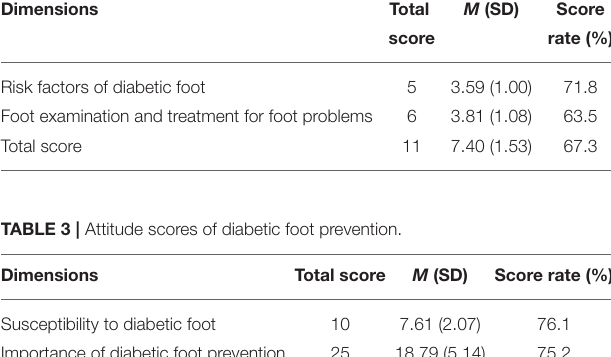
TABLE 1 | Sociodemographic and clinical characteristics of the study population ( n = 1,080).